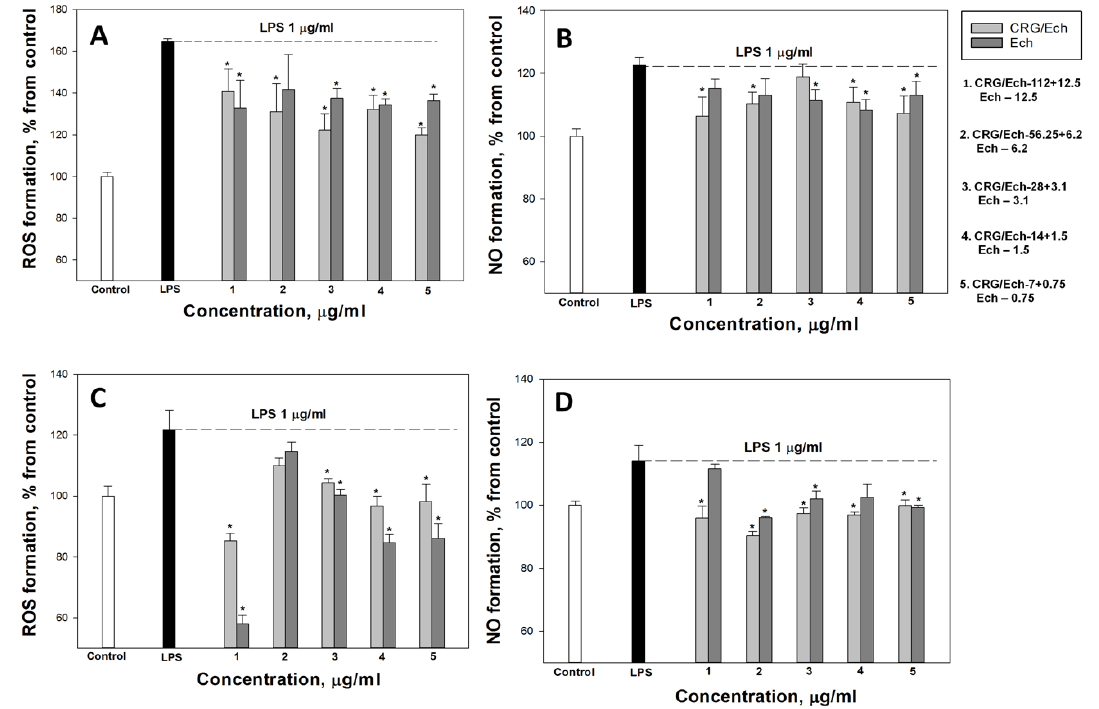
Figure 3. Effects of the CRG/Ech or Ech on intracellular ROS and NO formation in the murine macrophages cell line RAW 264.7 and peritoneal macrophages. The effects of the CRG/Ech or Ech on ROS formation into RAW264.7cells ( A ) and peritoneal macrophages ( C ) treated by 1 µ g/mL LPS. The effects of the CRG/Ech or Ech on NO formation into RAW 264.7cells ( B ) and peritoneal macrophages ( D ) treated by 1 µ g/mL LPS. Cells were incubated with CRG/Ech or Ech for 1 h at 37 ◦ C, then 24 h with LPS. The data are shown as the means ± SE; *— p < 0.05.